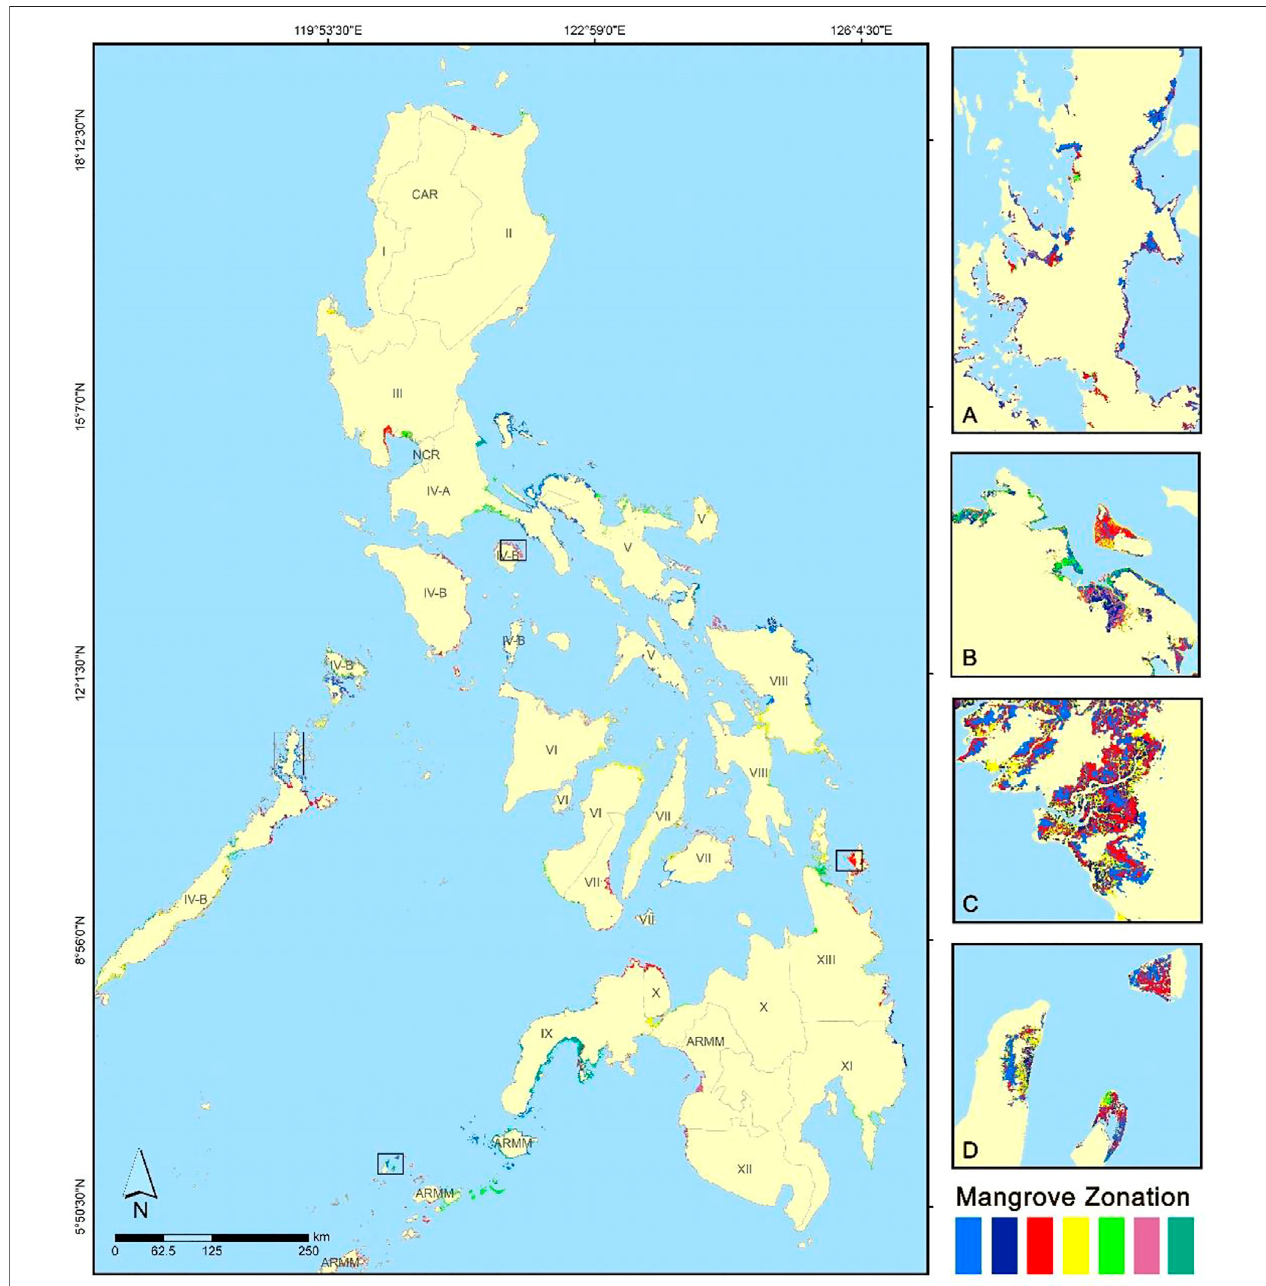
FIGURE 8 | Mangrove zonation map of the Philippines for year 2020 generated using Sentinel 2-derived indices and biophysical dataset. Zoomed-in mangroves zonation are shown for sample areas outside the initial study sites: (A) El Nido, Palawan, (B) Santa Cruz, Marinduque, (C) Del Carmen, Surigao de Norte, and (D) Pandukan and Kulassian islands, Sulu. The colors represent the different zonation per Sentinel-2 tile, but the corresponding actual mangrove zone for each color may differ between tiles. The generated zonation per satellite image ranges from three to seven zones, with varying clusters observed in different distances from the coast and